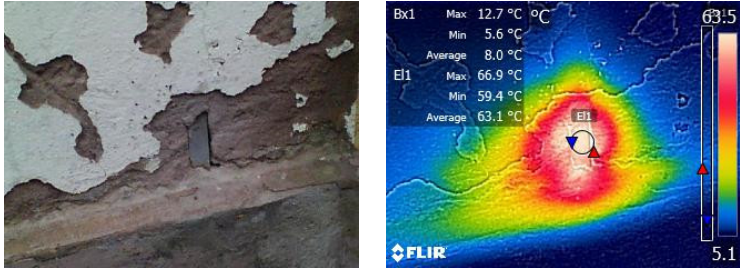
Figure 23. Thermal excitation of lightning protection installation.